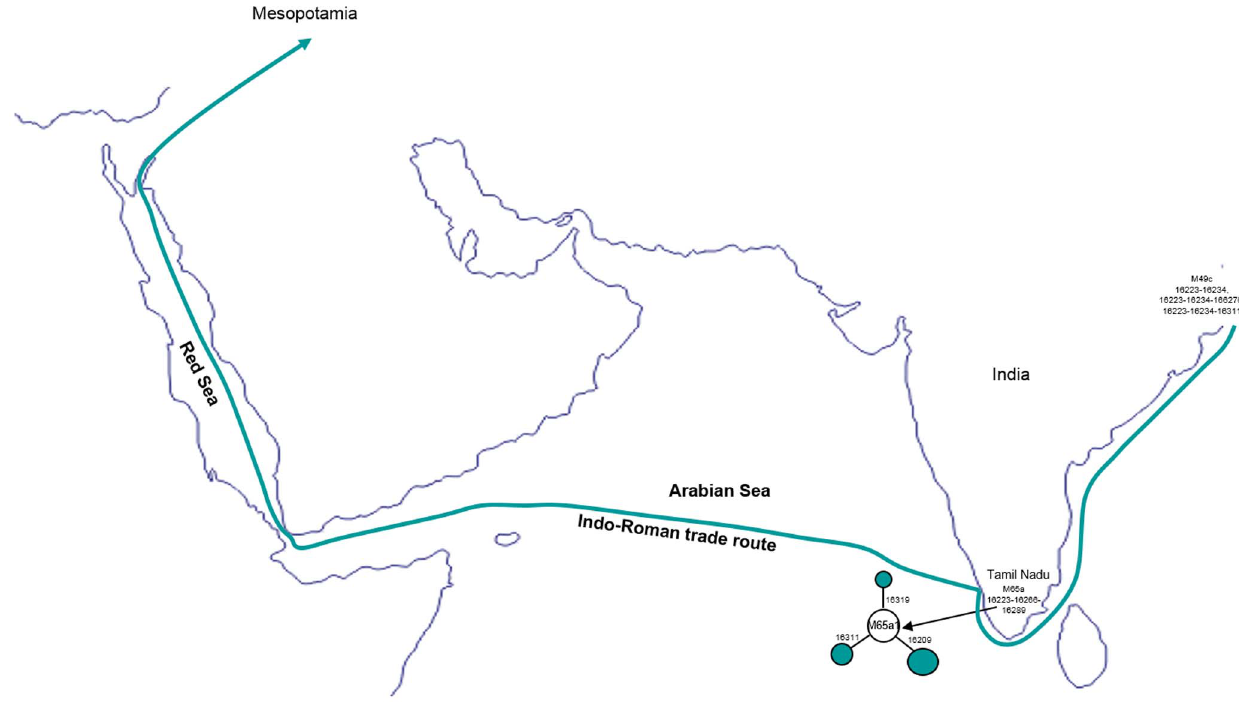
Figure 3. Ancient Indo-Roman maritime trade route. The geographic localization of ancient Mesopotamian mtDNA lineages M49c and M65a origin.